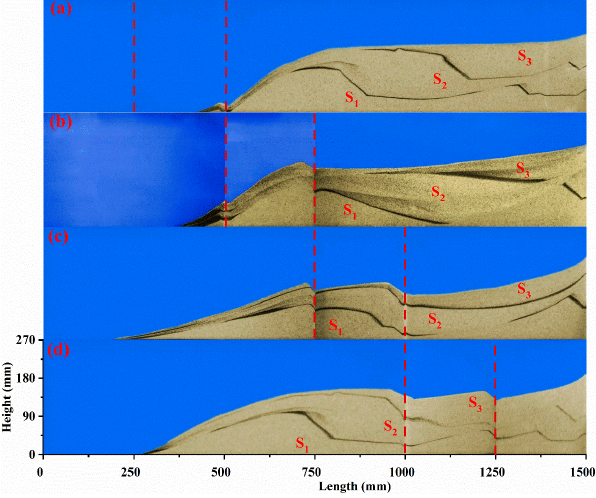
Figure 9. Snapshots of 40/70 mesh sand dunes in four channels at equilibrium at θ = 90°, Re = 3311 and S = 0.16, front view: ( a ) L 1 /L = 0.16; ( b ) L 1 /L = 0.33; ( c ) L 1 /L = 0.5; ( d ) L 1 /L = 0.66.